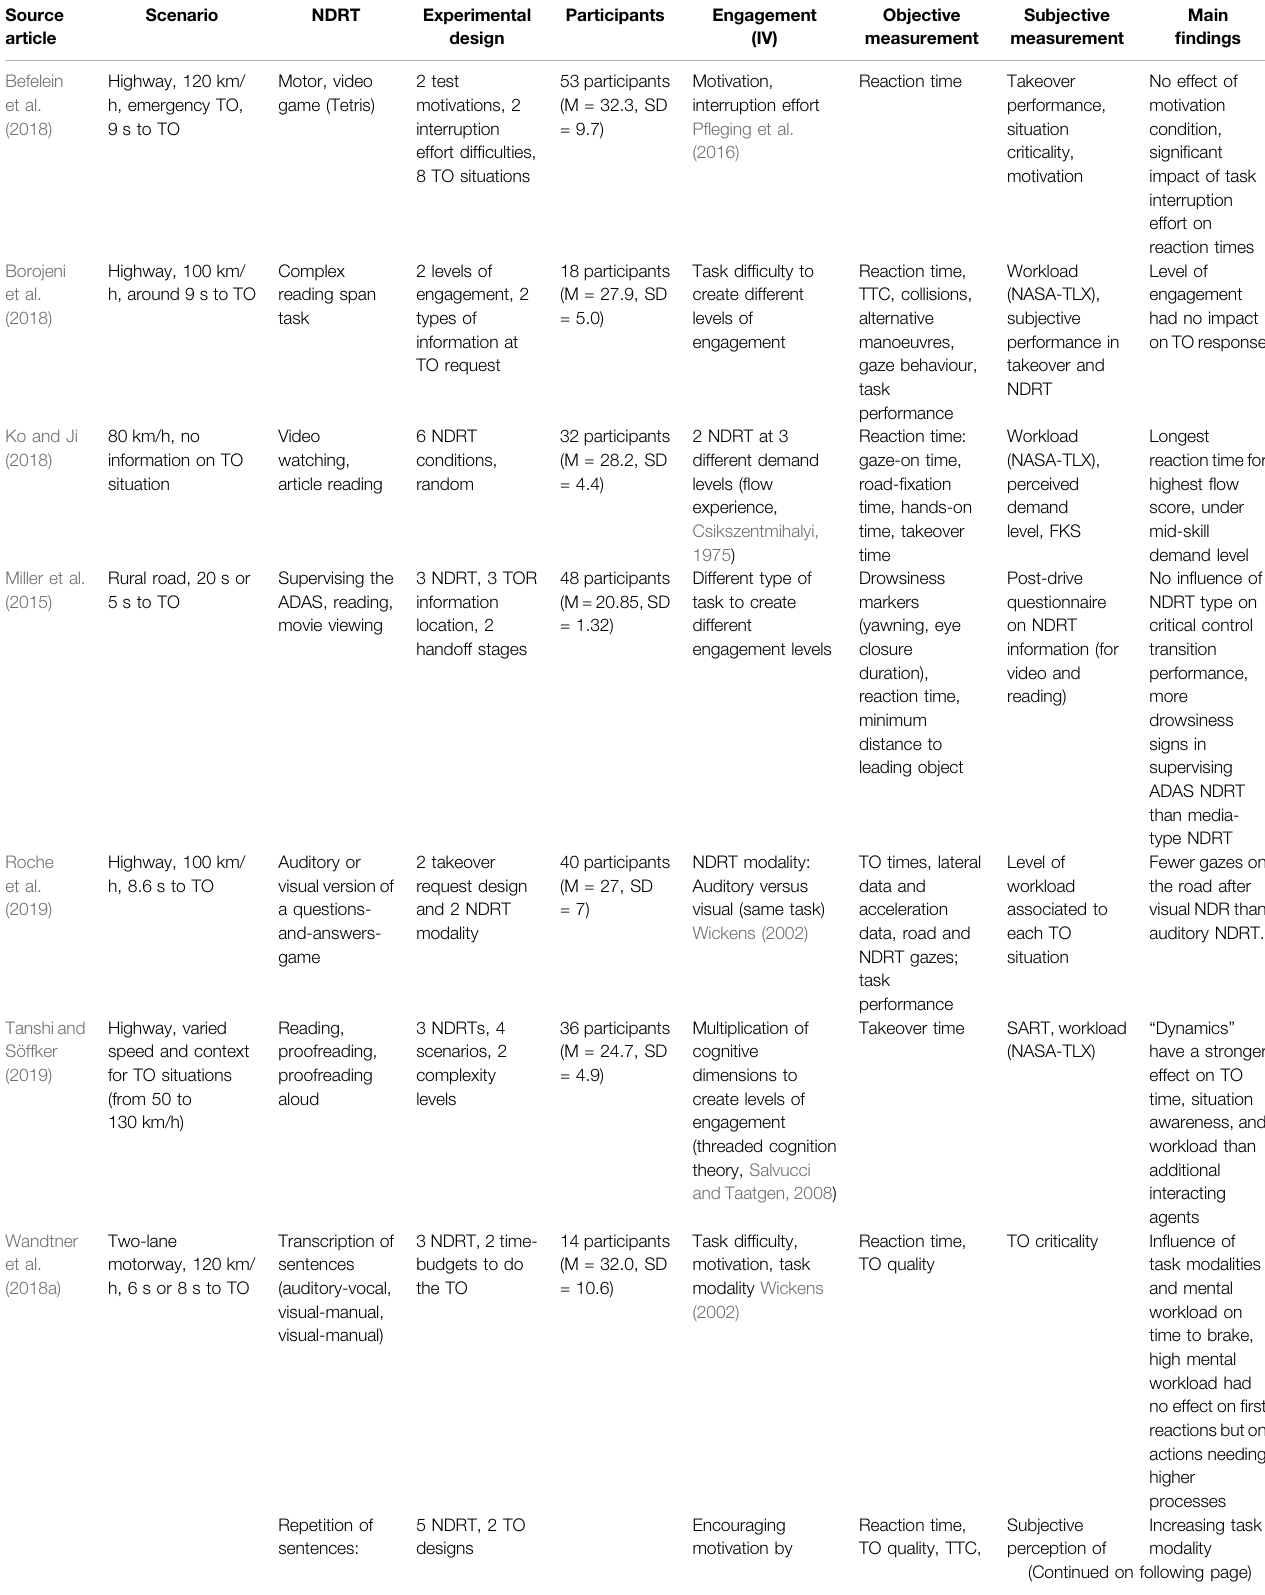
TABLE 2 | Studies using the manipulation of engagement as independent